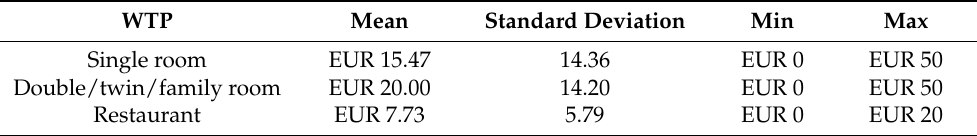
Table 3. The WTP for more accessible single rooms in hotels, double/twin/family rooms, and restaurants,